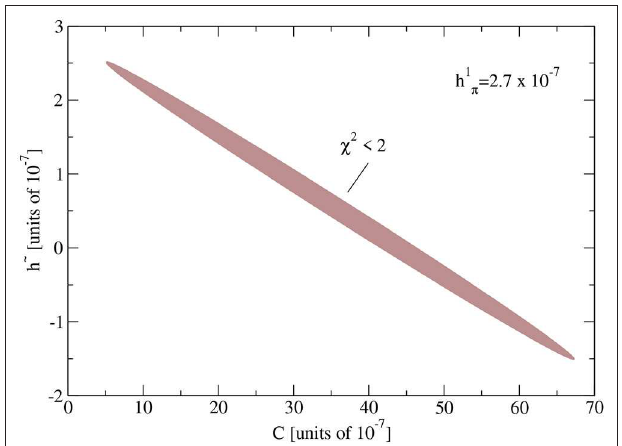
FIGURE 5 | Region of C and ˜ h values for which χ 2 longitudinal asymmetry. The calculation is based on the coefficients a ( pp ) 0 , a ( pp ) 1 , and a ( pp ) 2 reported in Table 5 assuming the value h 1 π